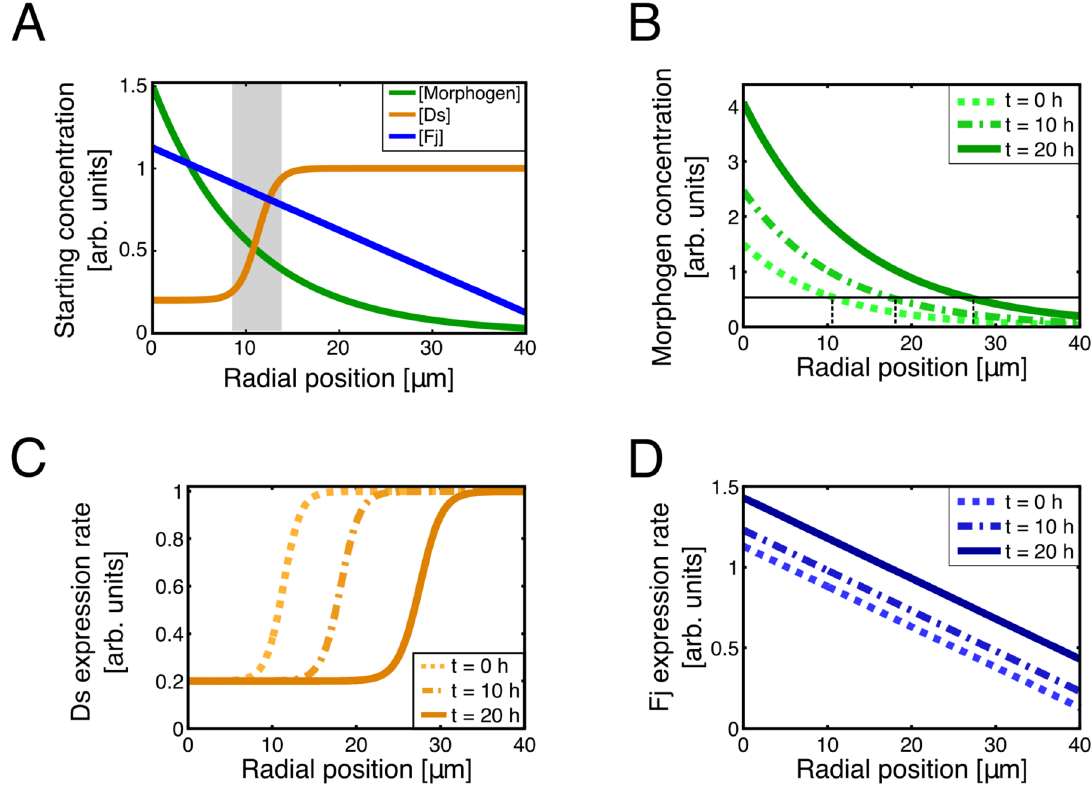
Fig 2. The expression patterns of morphogen, Fj, and Ds in the model change over time. (A) Initial concentrations of morphogen, Fj, and Ds as used in the model. The morphogen is most concentrated in the disc’s center and decays exponentially with radial distance(Eq 1). The Fj concentration is highestin the center of the disc and decreaseslinearlywith radial distance. Ds is expressedin response to the morphogenconcentration; it is most steeply gradedin a narrow portion of the disc (shadedregion). We refer to this as the “transition region.” The horizontal axis is the absoluteradial position,measured in μ m from the center of the disc. (A typical cell diameter in the model is 3–4 μ m.) The initial radius of the disc is about 40 μ m. The increasingamplitudeof the morphogen profile causes the Ds expressionfront to move outwardover time. (B) The morphogen concentration as a function of positionat 0 (dotted light green), 10 (dashedmedium green), and 20 hours (solid dark green) from the beginningof a typical run of the simulation. A radial positionof 0 correspondsto the center of the disc. The amplitude(i.e., the concentration at the disc’s center) increaseswith time. Consequently, the position at which the morphogen concentration equalsa given value, in this case 0.5 as indicatedby the horizontalline, moves radiallyoutward as indicatedby the vertical dashedlines. In addition, the morphogen profile scales with the overallradius of the disc, so its decay length increasesin time as the cells in the disc proliferate.Becausethe transition region corresponds to a morphogenconcentration of 0.5 on this plot, this mechanismmoves the Ds front outwardas well. (C) The Ds expressionrate profile as a function of position at 0 (dotted light orange),10 (dashedmedium orange),and 20 hours (solid dark orange)hours from the beginningof the simulation. Note that the Ds transition region, where the gradientis steepest, is a ring concentricabout the center of the disc that starts with a radiusof about 8 μ m and moves outwardover time. (D) The Fj expressionrate profile as a function of position at 0 (dotted light blue), 10 (dashedmedium blue), and 20 hours (solid dark blue) hours from the beginningof the simulation. The maximum concentration increaseswith time but the slope remains constant, so that the difference in Fj betweenadjacent cells does not vary substantially with time. Note that panelsC and D show the expressionrates of newly producedFj and Ds, not necessarily the instantaneous concentration profiles. However,the initial concentration profiles of Fj and Ds have a similar shape. A model of cell polarization should take into account the growth of the wing pouch and the time evolution of the Fj and Ds expression profiles. In particular, the Fj expression domain grows as the pattern of Vg expands, pushing the Ds domain to the edge of the wing primor- dium [5]. Although the mechanism governing the movement of the wing pouch boundary is little understood, it involves increasing Dpp signaling [32] combined with the tendency of Dpp signaling to affect Fj and Ds expression [7].